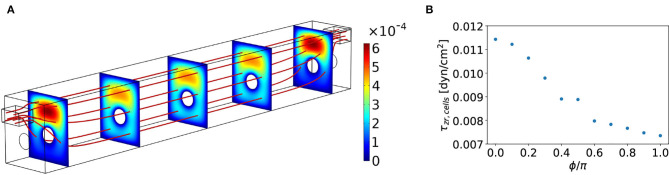
(A) Steady-state velocity field uz(r) in the experimental flow channel, the magnitude is indicated with the colorbar in (m/s). The red lines indicate streamlines and the cut planes show the velocity magnitude. The dimensions are as indicated in Figure 1C and the channel has a total width of 3 mm and height of 3.65 mm. An aqueous fluid with viscosity η= 0.78mPa s and density ρ= 997.8 kg/m3 flows through the device at a steady flow rate of Q0= 125 μL/min. (B) Shear stress on the cells τzr, cells in the center of the microfluidic device as a function of the azimuthal angle ϕ around the fiber. Here, ϕ = 0 corresponds to the top of the fiber.